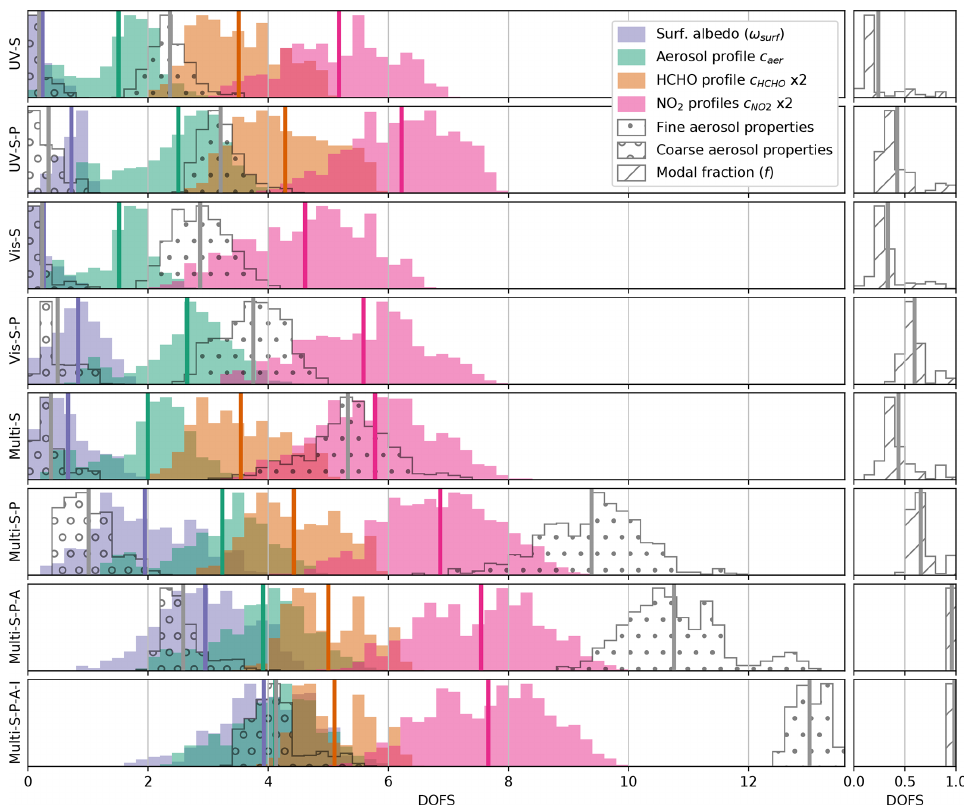
Figure 3. Visualisation of the DOFS as shown in Table 6. Shown are histograms of the DOFS obtained for different parameter subgroups (see legend). Each occurrence corresponds to one atmospheric scenario. To reduce overlap between the histograms, HCHO and NO 2 profile histogram values have been multiplied by 2. Subplot rows show different measurement modes according to the labels on the left axes. Thick vertical lines indicate median values. The histograms are peak-normalised, so that the vertical axes indicate the number of occurrences in arbitrary units. For extra clarity, histograms for the modal fraction f are shown in separate panels on the far right of the figure. For aerosol properties, the aerosol scenario Aer0 (no aerosol) was excluded